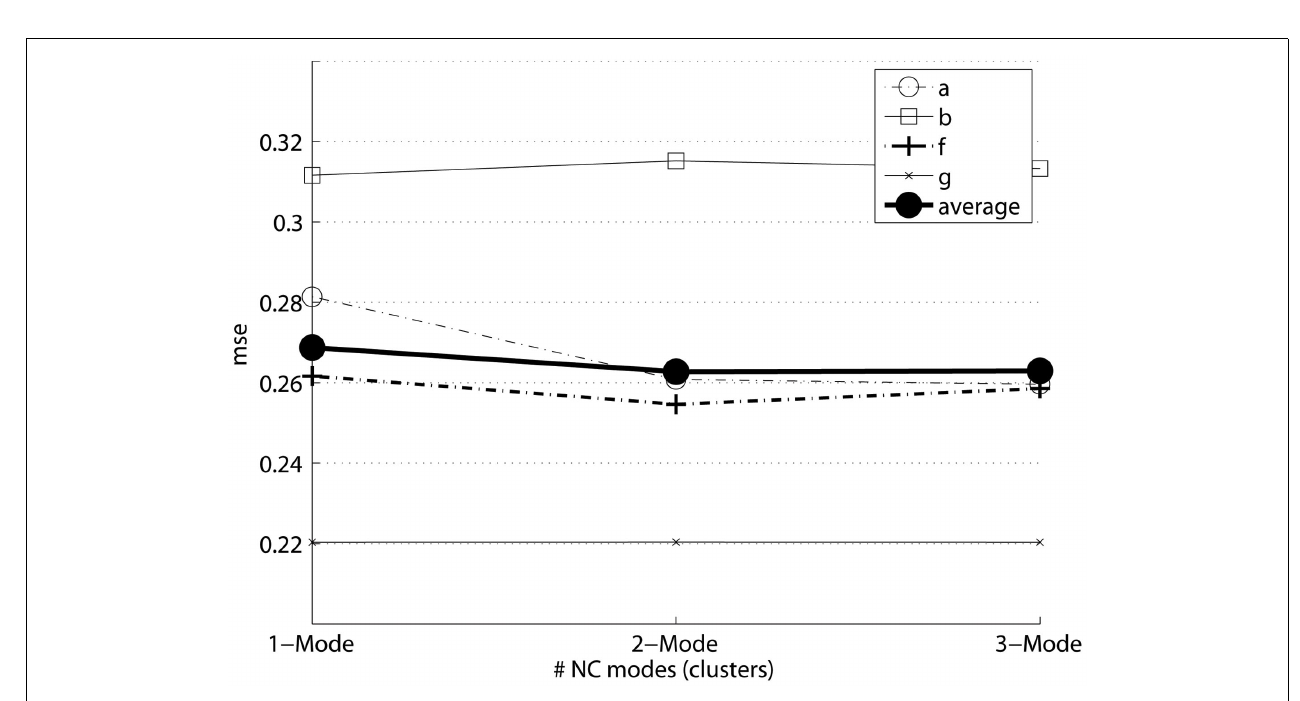
FIGURE 2 | Mean-square-error of class label prediction with respect to the time interval of a motor imagery trial extracted for training data.